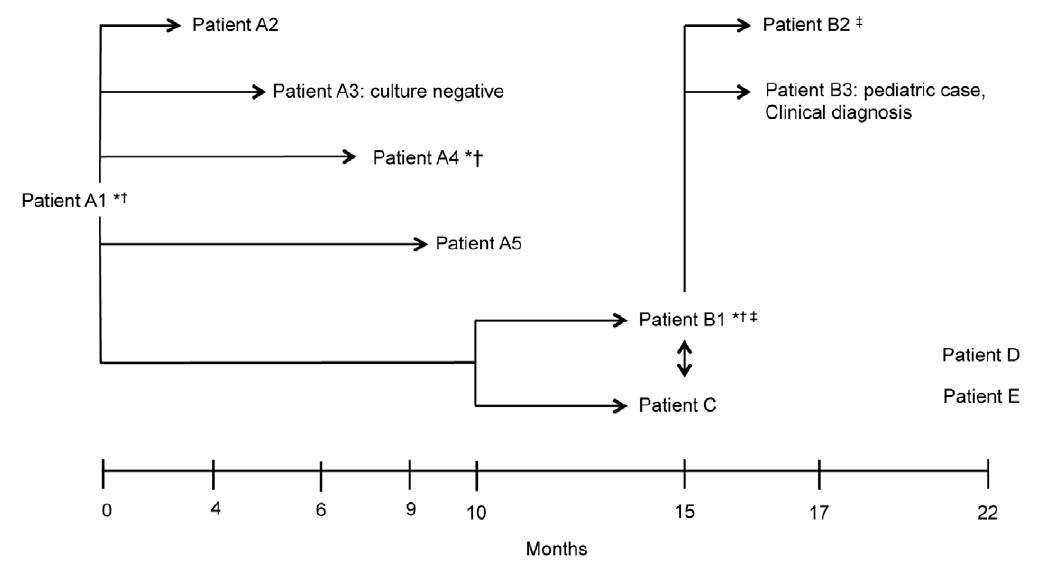
Figure 1. Timeline (months) and characteristics of the patients involved in the outbreak. The epidemiological links are shown with arrows. *Chest radiograph showing cavitation. { Positive sputum smear examination. { Laryngeal tuberculosis.